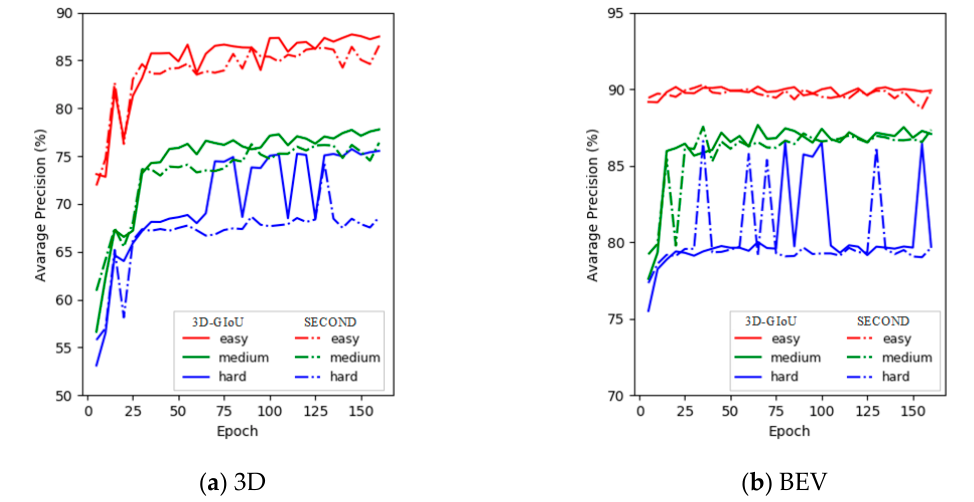
Figure 7. 3D-GIoU vs. SECOND for the detection performance of 3D and BEV evaluation on the KITTI validation set across three difficulty levels (i.e., Easy, Moderate and Hard). In ( a ) and ( b ), the solid line represents 3D-GIoU, while the dotted line represents SECOND.